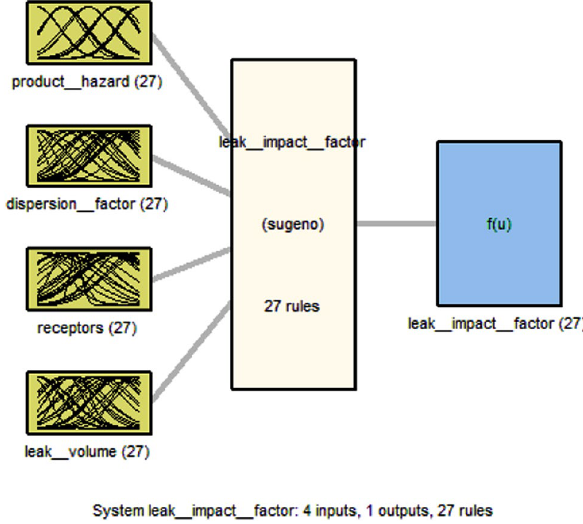
Figure 6. Leak impact factor fuzzy inference structure.